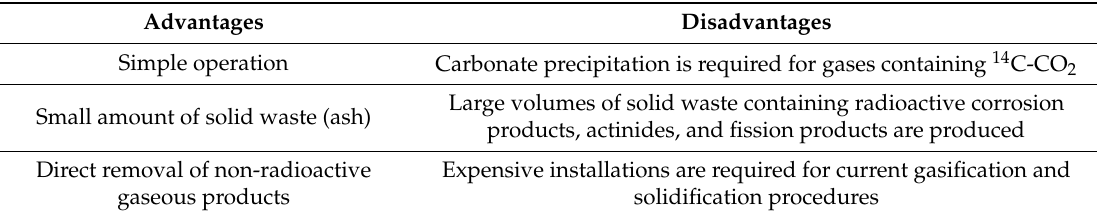
Table 2. Main features of the gasification of radioactive waste containing i -graphite.